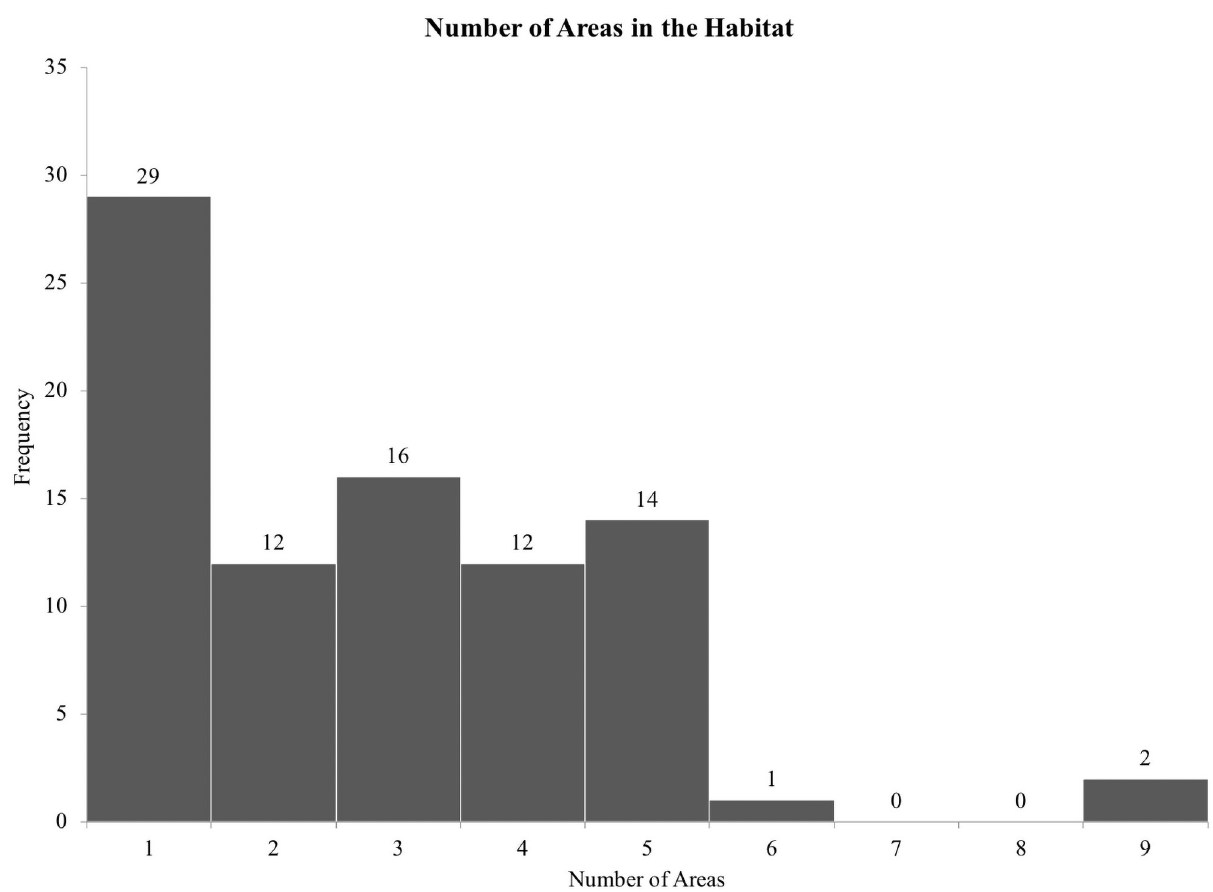
Fig 5. Number of areas in the habitat. The total number of areas the habitat could be separated into.